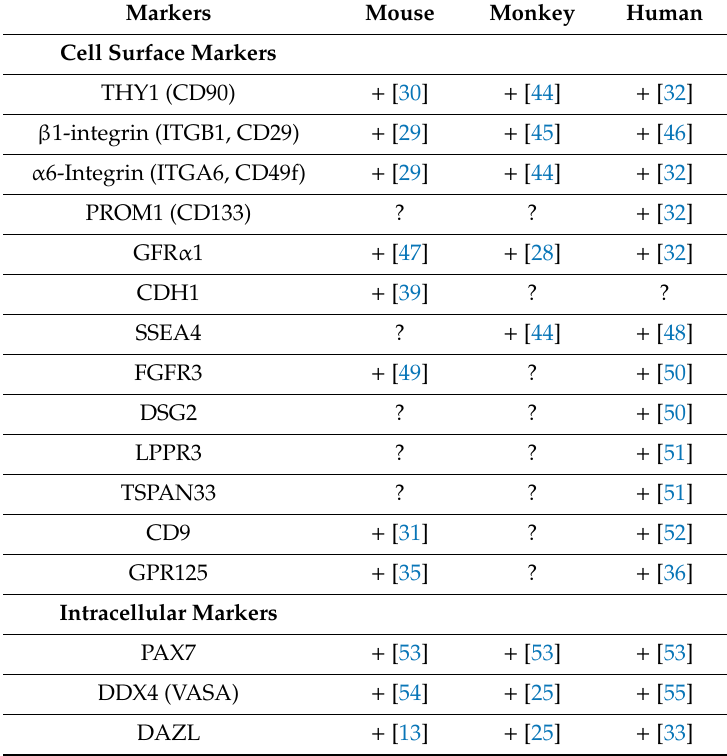
Table 1. Molecular markers of undi ff erentiated spermatogonia in primates and mice. Markers